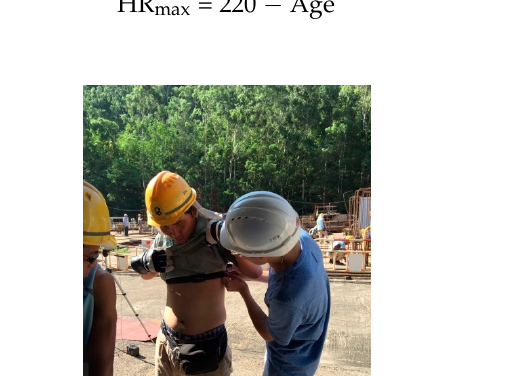
Figure 2. Heart rate belt (Polar Wearlink ® USA).